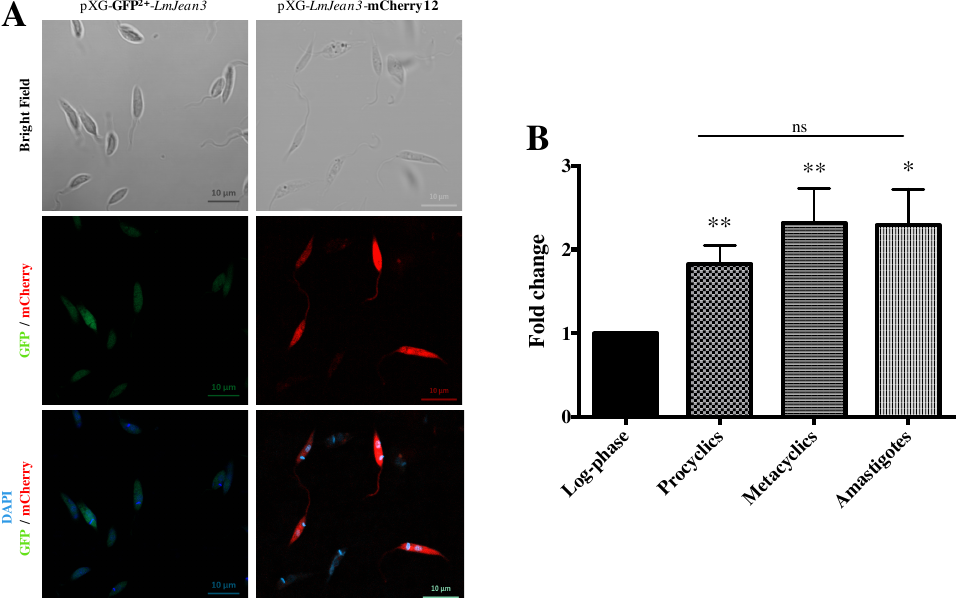
Figure 2. LmJean3 was localized in the cytoplasm of L. major parasites, and its gene expression level s doubled in the stationary phase. ( A ) Visualization of L. major promastigotes expressing GFP 2 + -LmJean3 (left lane) or LmJean3-mCherry (right lane) fusion proteins; ( B ) relative expression quantification of LmJean3 from log-phase, procyclic, and metacyclic (infective) promastigotes and from intracellular amastigotes. Bars represent gene expression mean fold change ( ± SD) from three independent experiments (* p < 0.05; ** p <